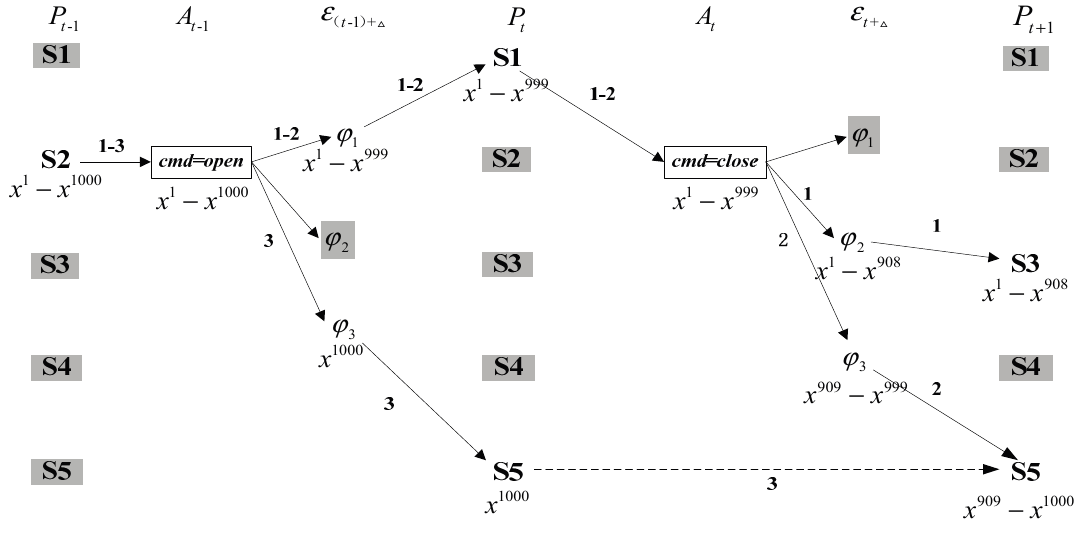
Figure 4. Two time-step state estimation using LUG for